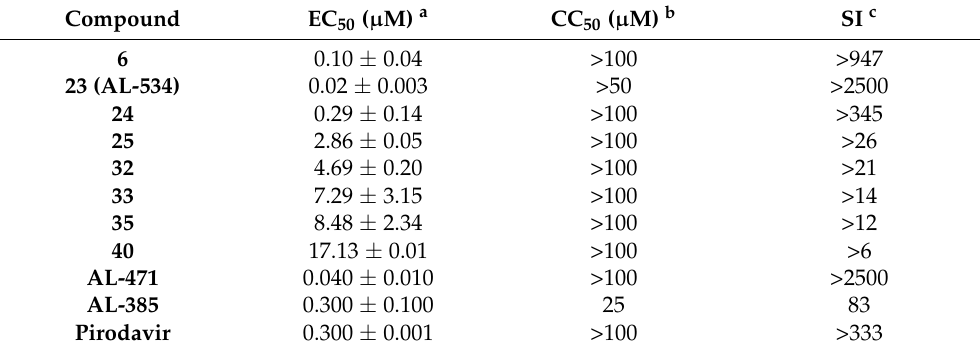
Pirodavir 0.300 ± 0.001 >100 >333